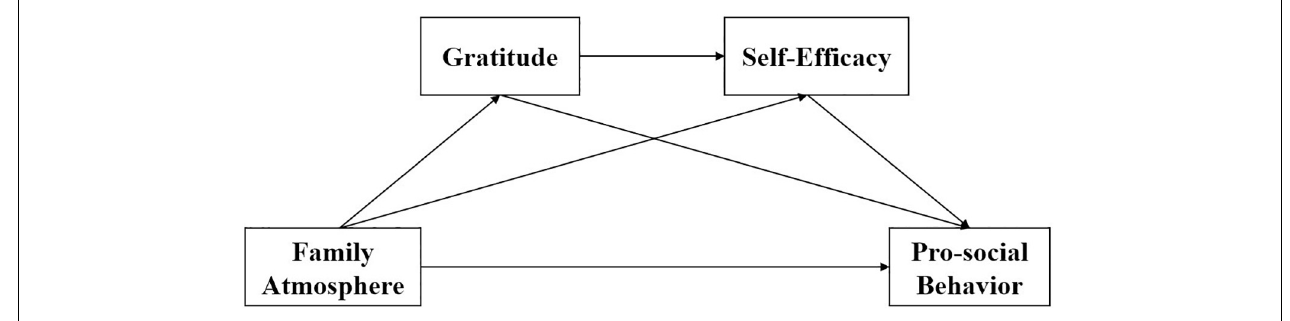
FIGURE 1 | Hypothetical model of the relationship between the family atmosphere, gratitude, self-efficacy, and pro-social behavior.